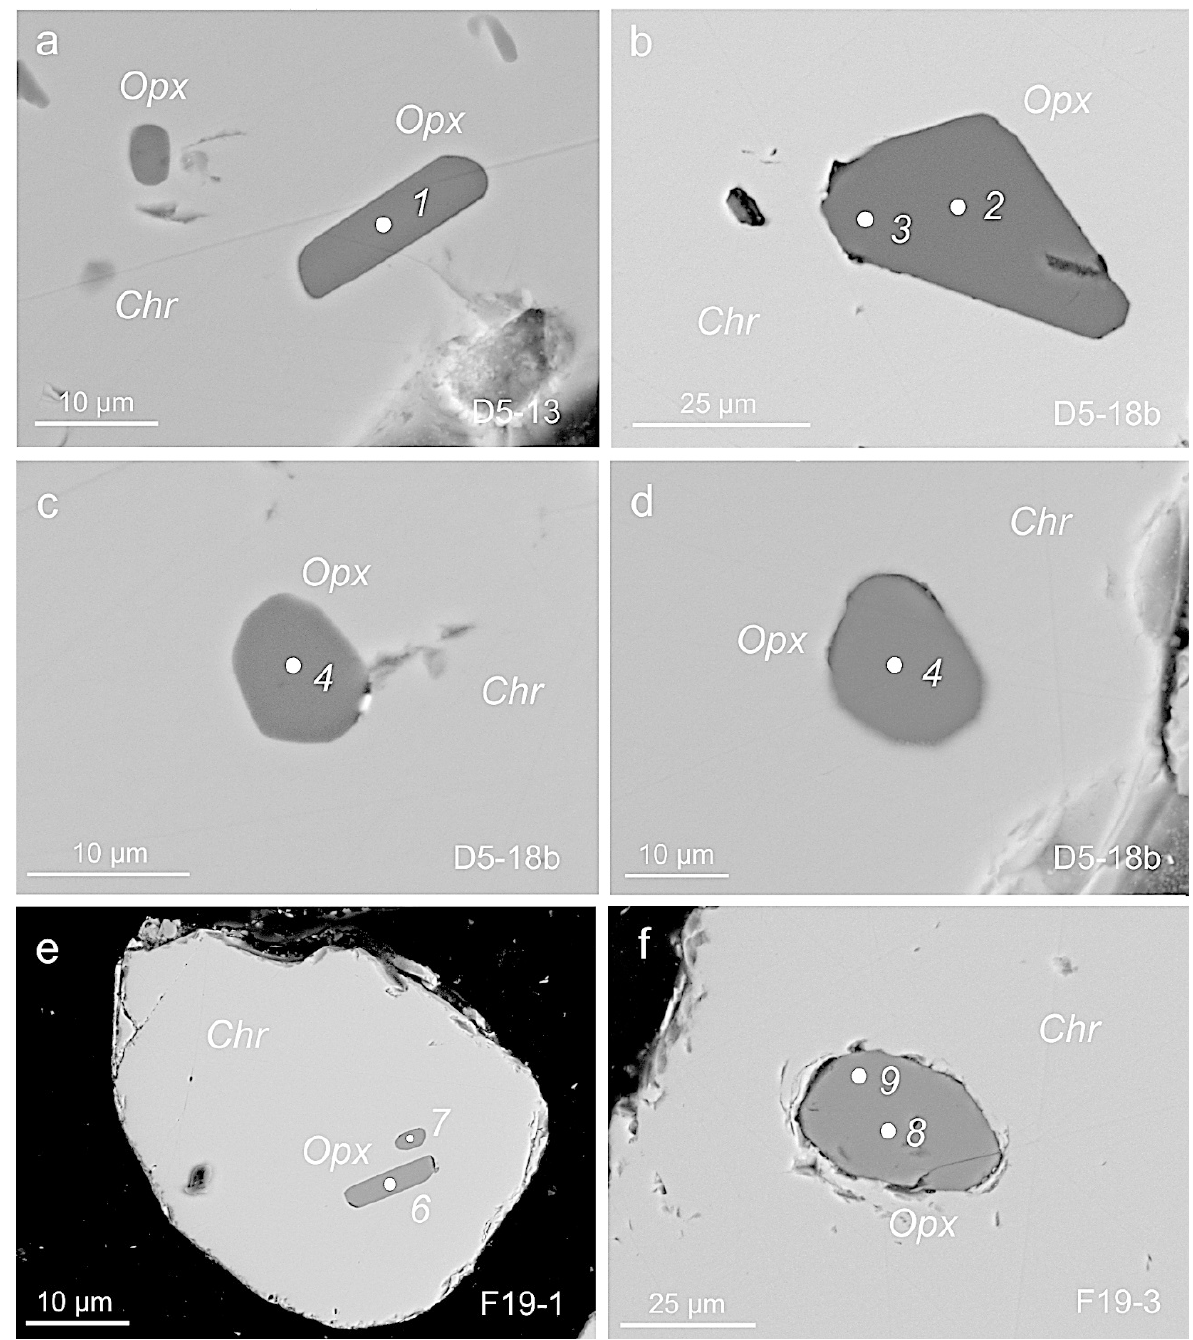
Figure 14. BSE images of monomineralic orthopyroxene (Opx) inclusions in chromspinels (Chr) from the Sabantuy paleoplacer (samples D 5 -13, D 5 -18b, F 19 -1, F 19 -3): ( a , b ) prismatic orthopyroxene inclusions, ( c , d ) small sub-rounded orthopyroxene inclusions, ( e ) prismatic orthopyroxene inclusions, ( f ) sub-angular orthopyroxene inclusion. Note: the numbers indicate the points of the compositions presented in Table 5. Table 5. The composition of monomineral orthopyroxene inclusions in chromite (wt.%).